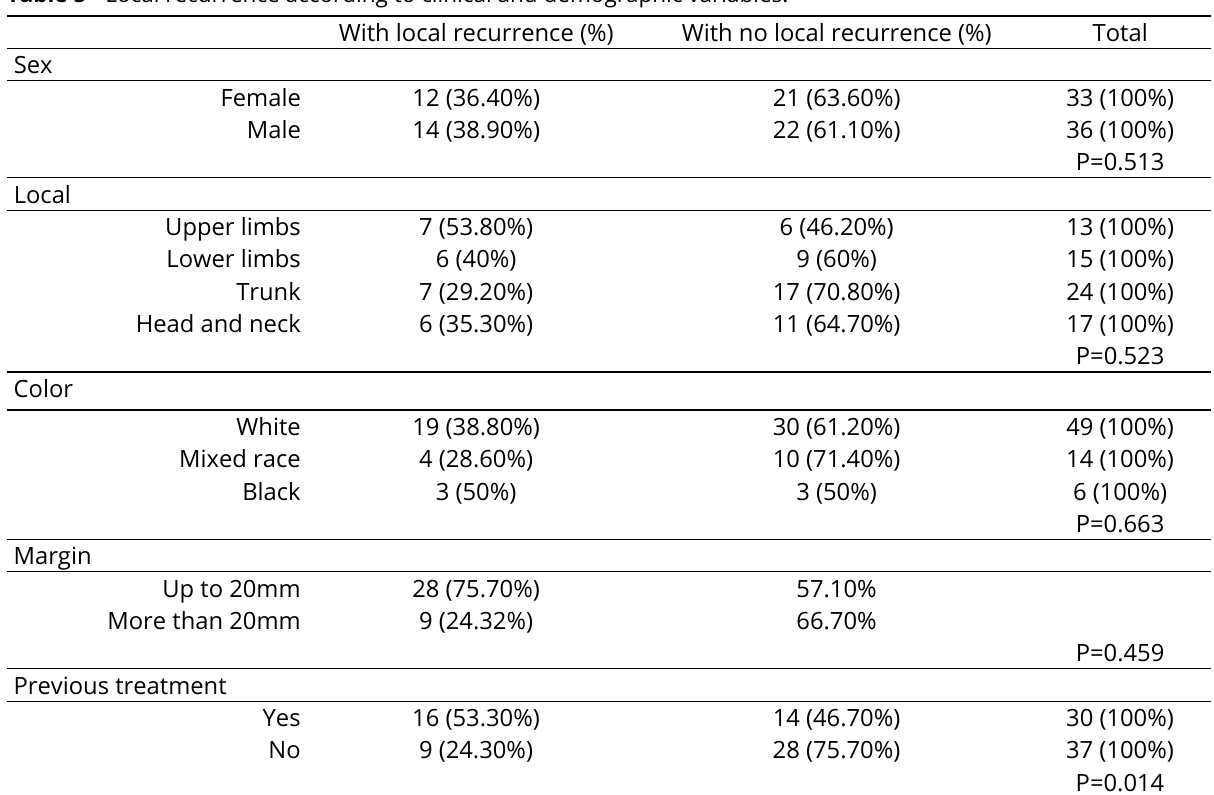
Table 5 - Local recurrence according to clinical and demographic